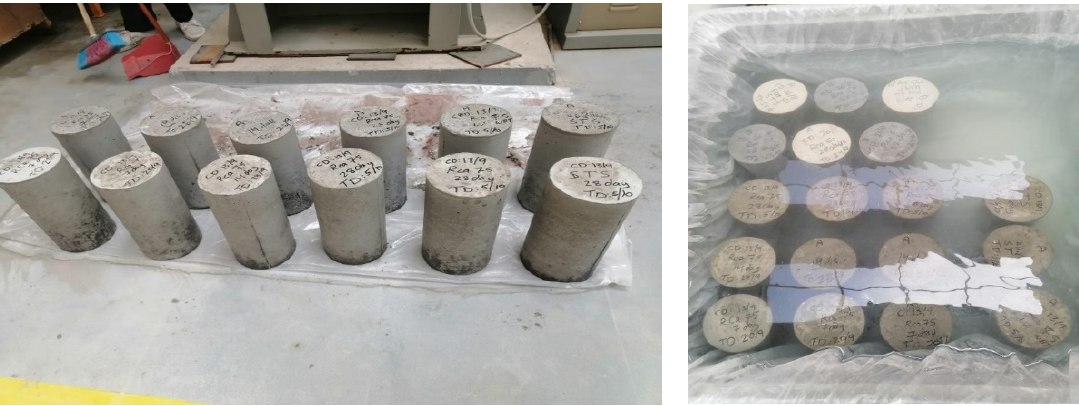
Figure 3. Concrete cylinder demolding and curing .